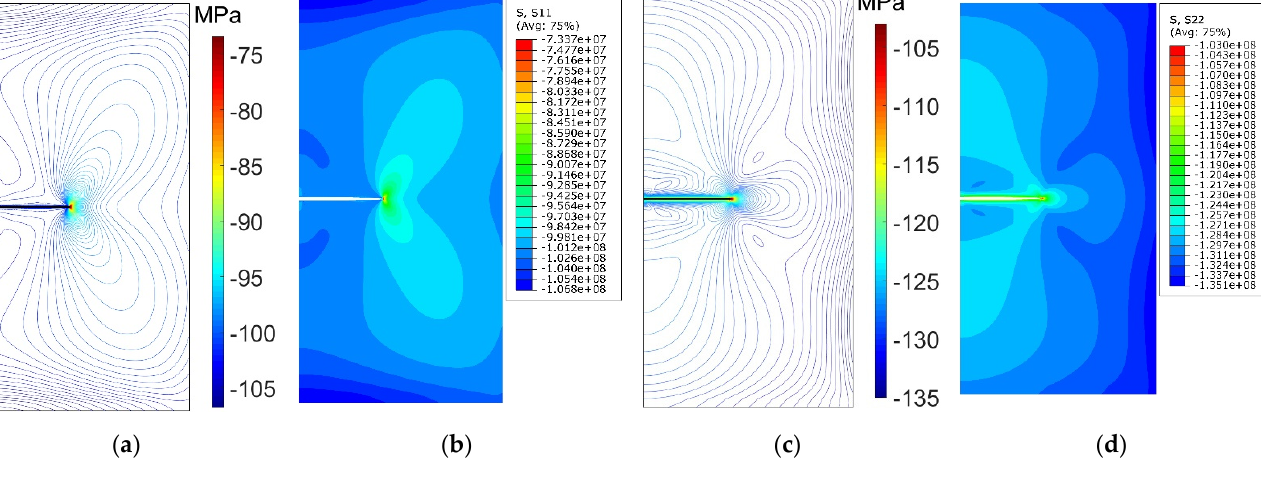
( c ) Figure 9. Evolutions of plastic zone during hydraulic fracturing after the following times: ( a ) 1.6 × 10 1 s; ( b ) 1.23 × 10 2 s; and ( c ) 3.58 × 10 2 s.